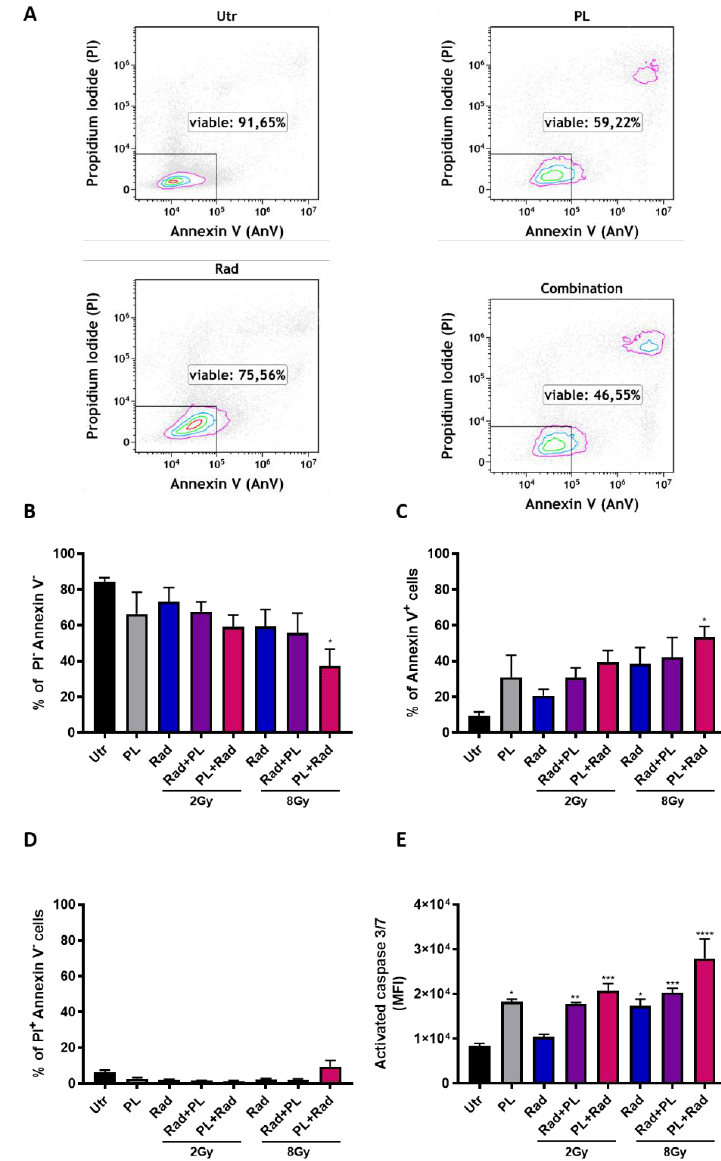
Figure 2. Gas plasma and single-dose radiotherapy induced apoptosis in an additive fashion. ( A ) representative dot plots of Annexin V and propidium iodide (PI) flow cytometric analysis in B16F10 cells 24 h post-exposure to plasma (15 s), radiotherapy, or both; ( B – D ) quantification of viable ( B ), apoptotic ( C ), and necrotic ( D ) cells; ( E ) additional confirmation of apoptosis using the cell event caspase 3/7 dye. Data are representative and mean + SE of three experiments. Statistical analysis was